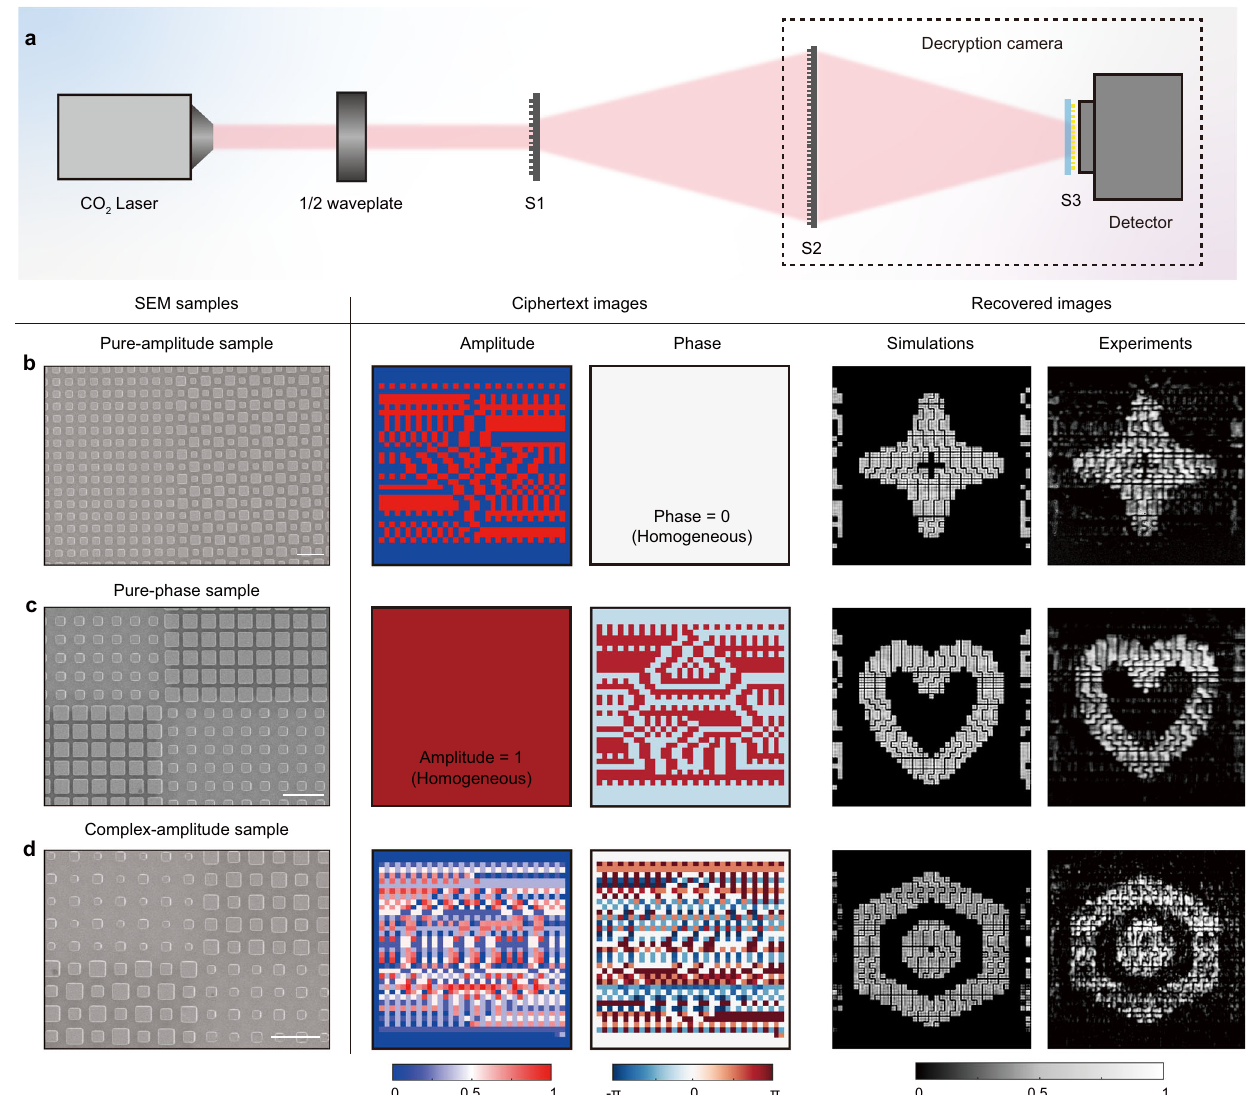
Fig.3|Experimentalsetupanddecryptionresults.a Experimentalsetup.S1toS3 represent the optical ciphertext, spin-multiplexed metalens, and the vector polarizer, respectively. b – d Simulated and experimental imaging results of three kinds of optical ciphertexts with binary pure-amplitude, binary pure-phase, or